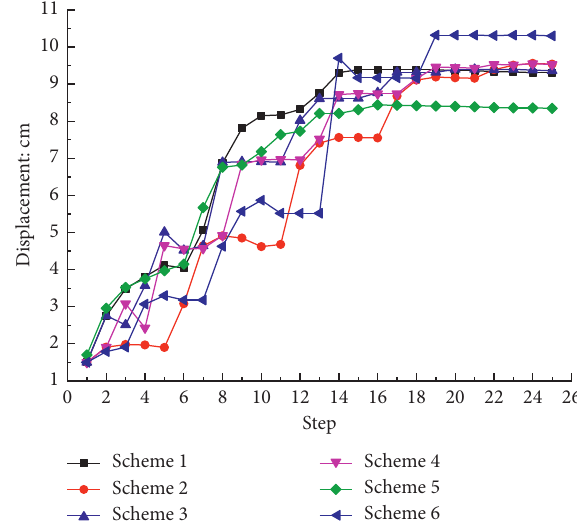
Figure 4: Displacement curve of schemes 1–6.